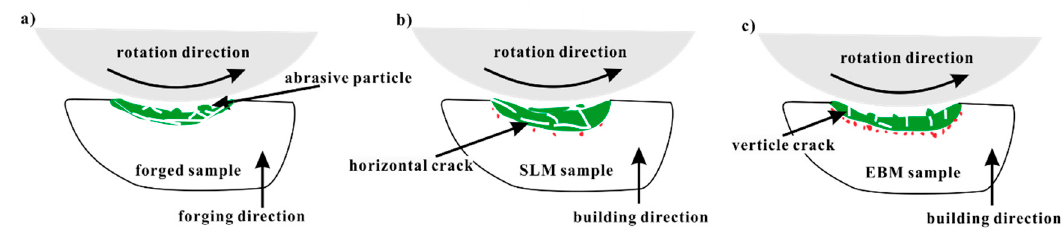
Figure 10. Schematic illustration of the wear mechanisms in Ti-6Al-4V samples produced by ( a ) forging, ( b ) SLM and ( c ) EBM processes.